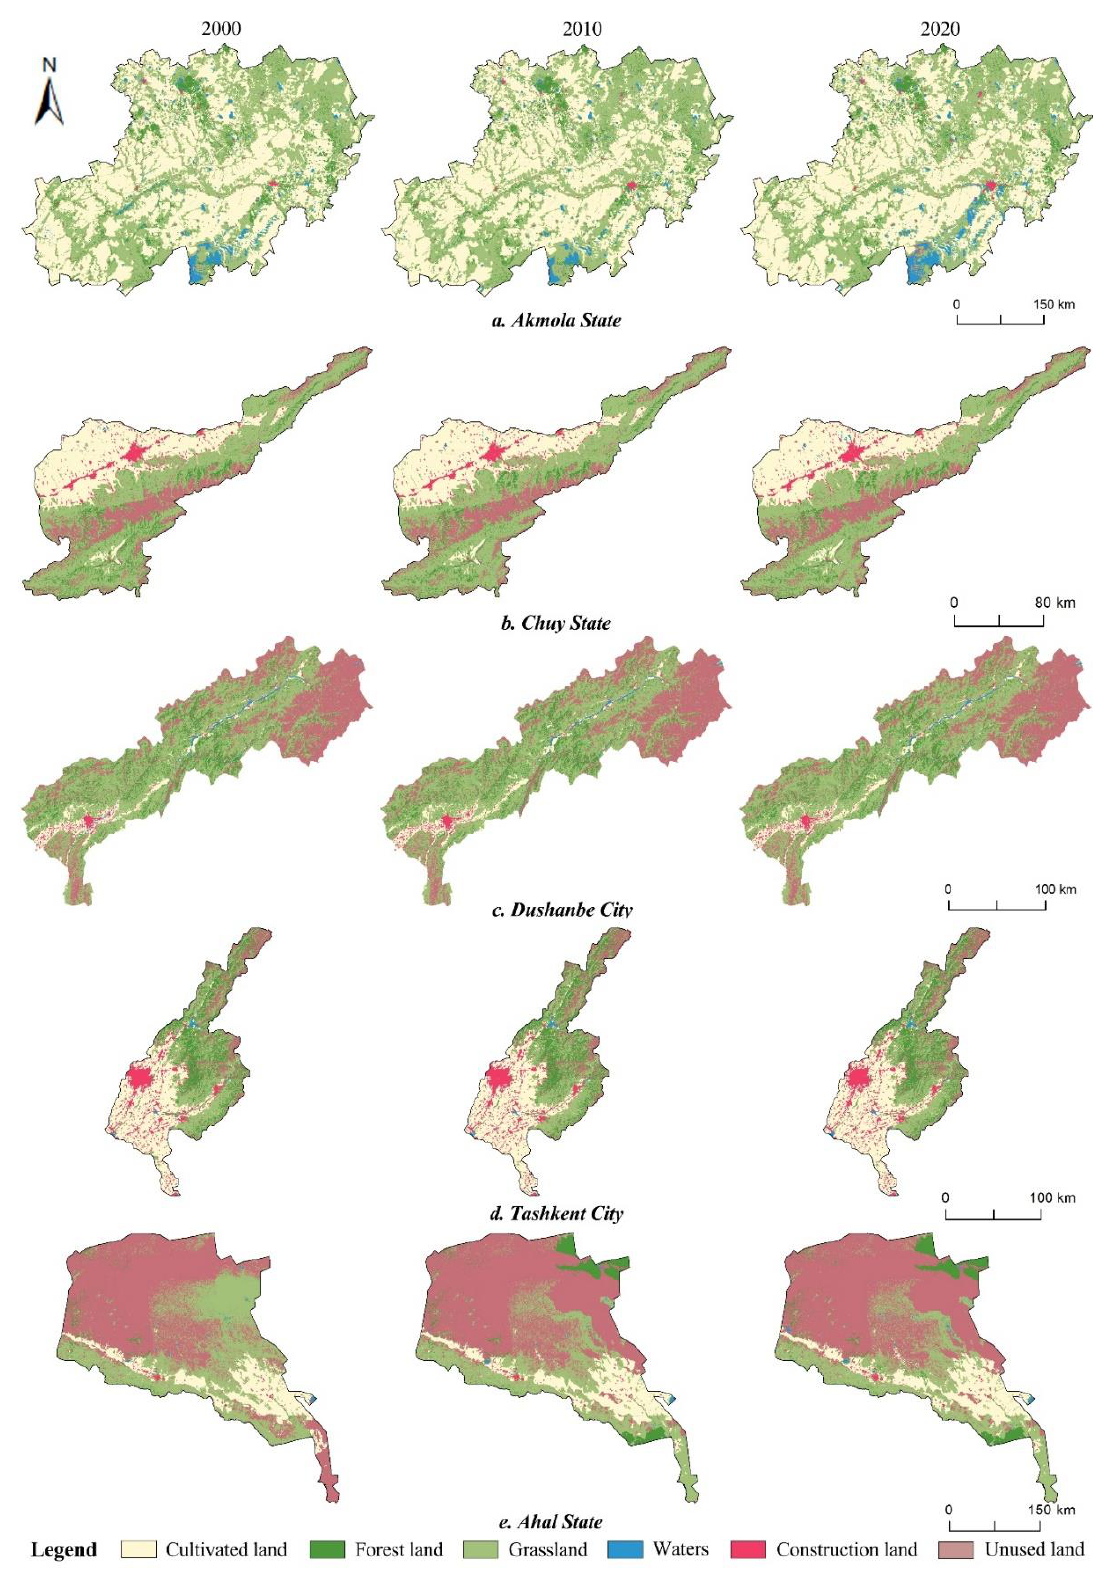
Figure 3. ( a – e ) Spatial distribution map of land use change. The cultivated land area of Akmola State decreased by 953.12 km 2 from 2000 to 2020 but increased from 2010 to 2020. The total area of forestland decreased by 1312.45 km 2 , with a dynamic degree of − 1.26%. Meanwhile, the dynamic degree toward forest land use in 2010 – 2020 was greater than that in 2000 – 2010. During 2000 – 2010 and 2010 – 2020, the water and unused land areas first decreased then increased. However, the water area de- creased greatly during 2000 – 2010, and the unused land area increased the most during